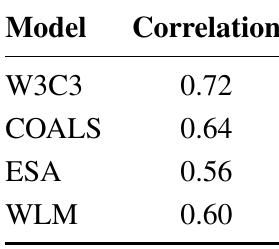
Table 7. Correlations with WordSimilarity-353 without missing word